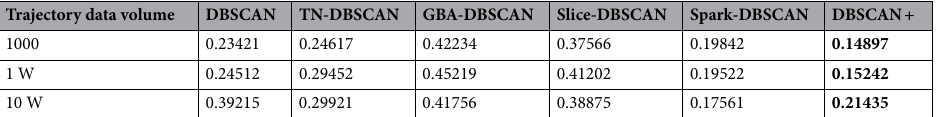
Trajectory data volume